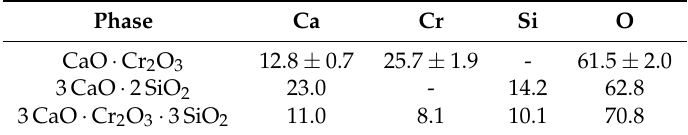
Table 5. Chemical composition of phases in slags given in Figure 4, determined using energy dispersive spectroscopy (EDS) (at-%).